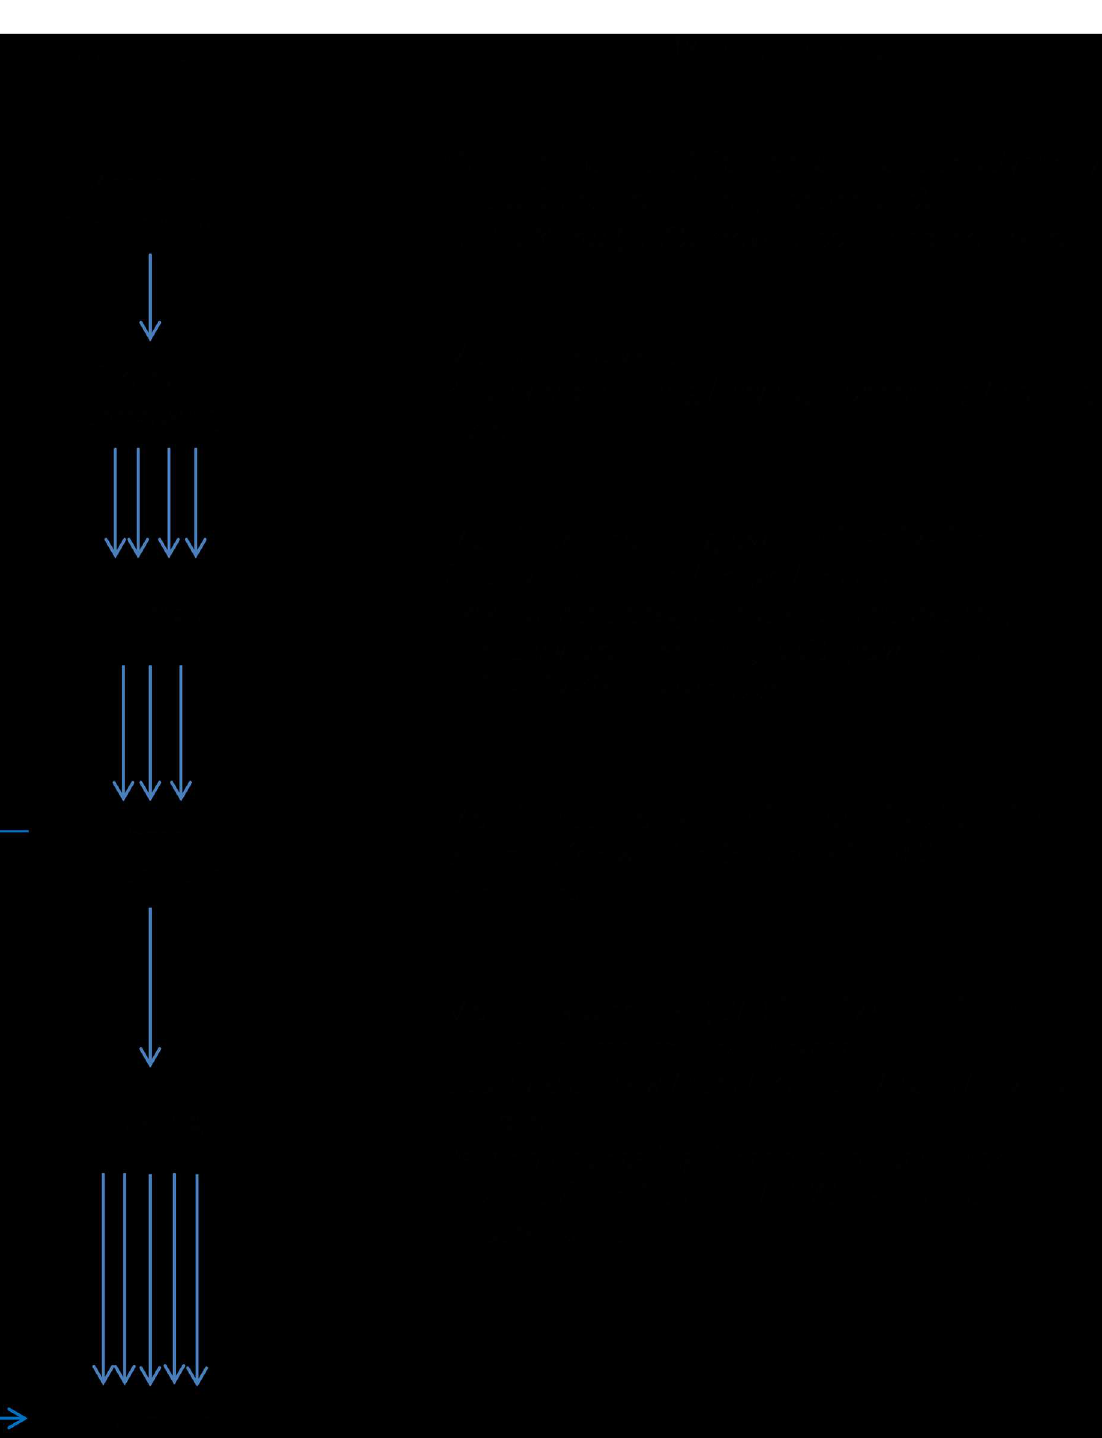
PLOS ONE | DOI:10.1371/journal.pone.0169589 January5,